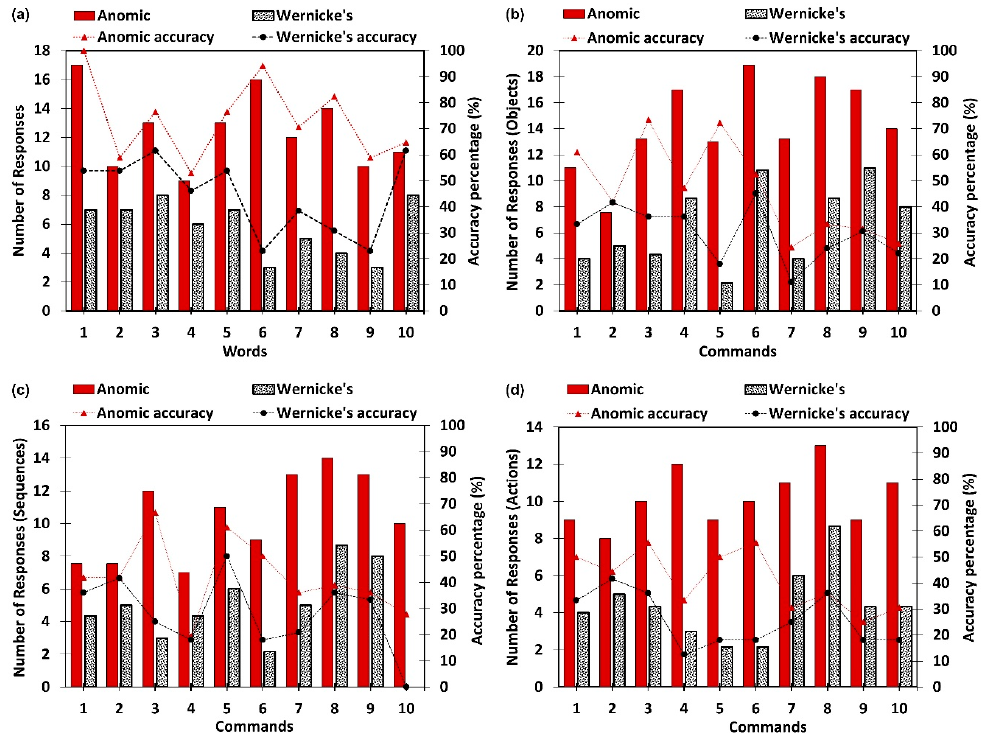
Table 3. Performance analysis summary of repetition task.